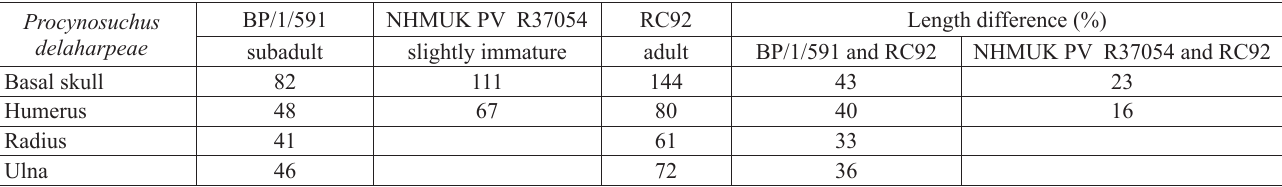
Table 3. Length (in mm) of skull and long bones of Procynosuchus specimens and the percentual size differences between the specimens.